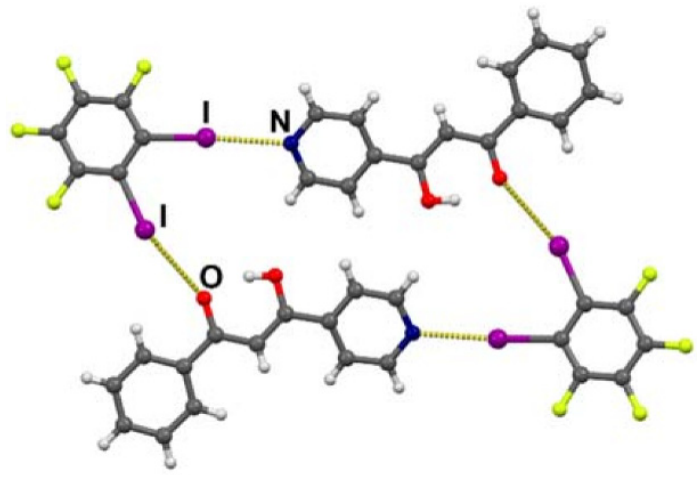
Figure 2. Co-crystal of 3N with 1,2-di-iodo-3,4,5,6-tetrafluorobenzene. Taken from Ref. [66].